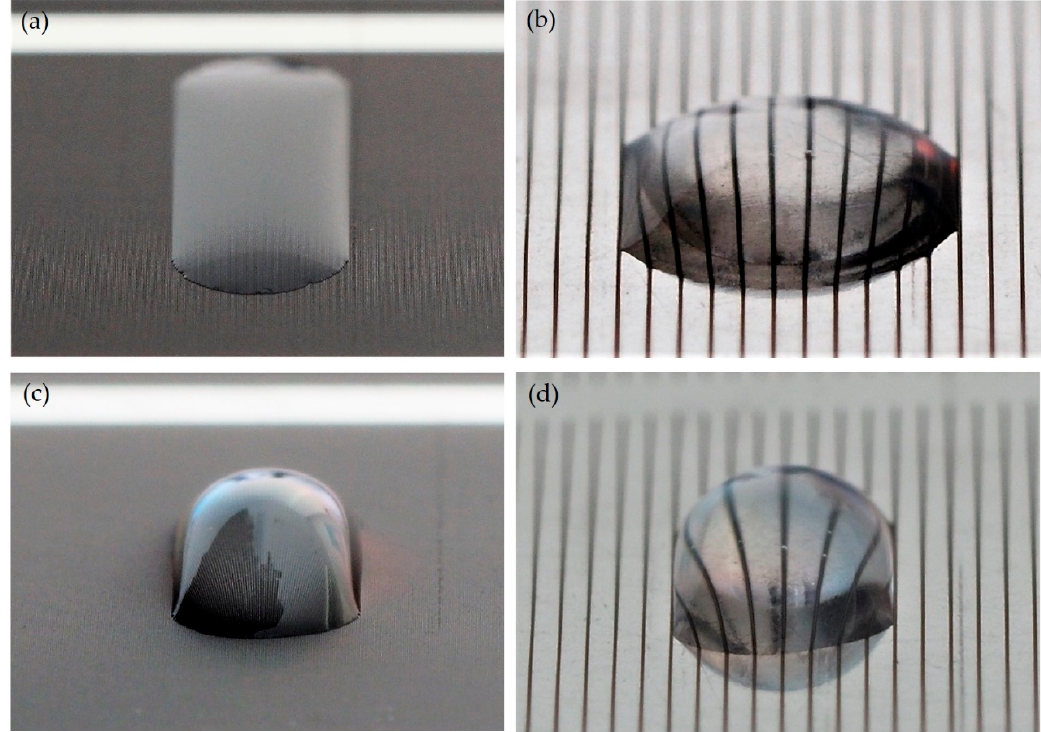
Figure 5. Selected images of droplet shape evolution on laser-structured surfaces over time. ( a ) Droplet shape after 1 day and ( c ) 15 days of storage on a deterministic line structure with a 1-µm strut width. ( b ) Droplet shape after 1 day and ( d ) 15 days of storage on a deterministic line structure with a 300-µm strut width.